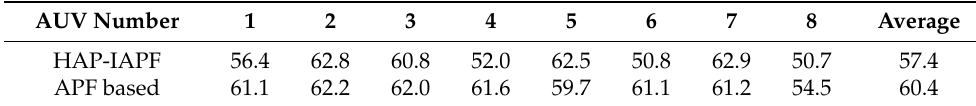
Figure 8. Cooperative hunting process based on the HAP-IAPF method in a dynamic obstacle envi- ronment.